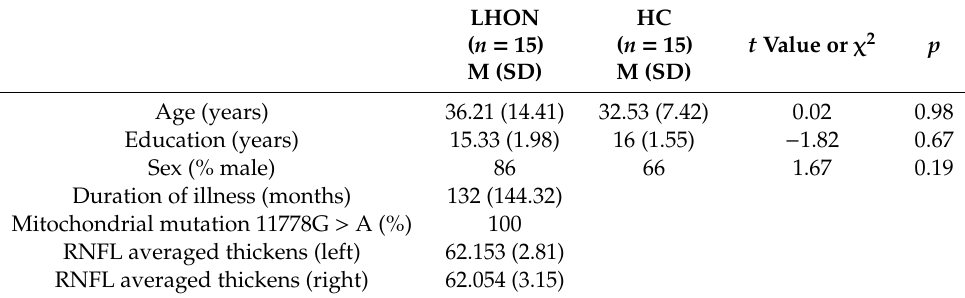
Table 1. Demographic and clinical data of research groups.